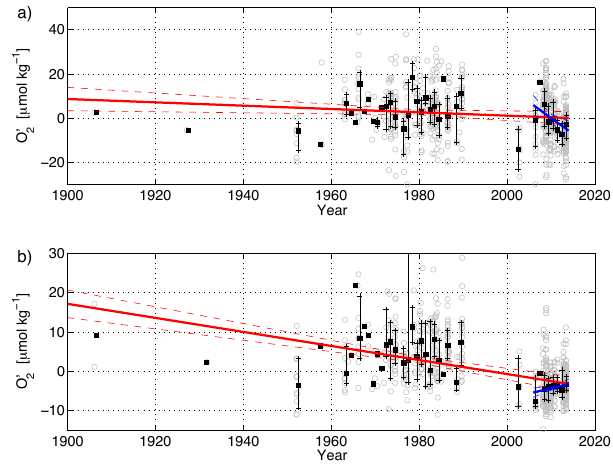
Figure 18. Oxygen trend along 23 ◦ W between 20 and 26 ◦ W and between 1972 and 2013 as obtained from the MIMOC climatol- ogy (Schmidtko et al., 2013). The trend was calculated on depth coordinates using oxygen anomalies relative to mean oxygen. Thin black contours mark mean oxygen (µmolkg − 1 ), thick black con- tours mark potential density (kgm − 3 ), both from the MIMOC cli- matology.